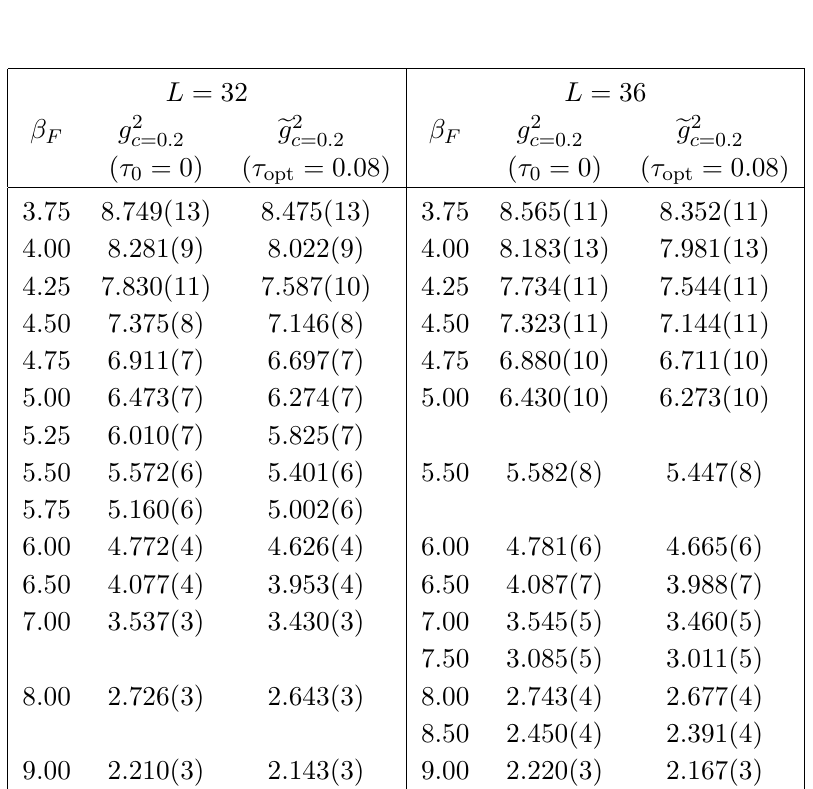
Table 14 . Renormalized gradient (cid:13)ow couplings in the c = 0 : 2 scheme for the 32 4 and 36 4 lattice ensembles used in this work, with columns as in table